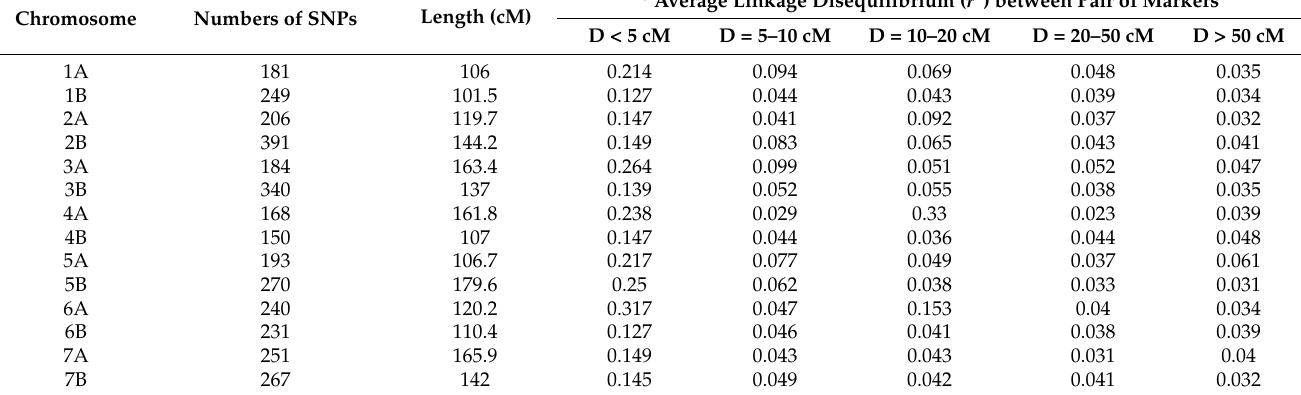
Table 2. Average linkage disequilibrium ( r 2 ) at different marker distances for 139 durum wheat accessions.